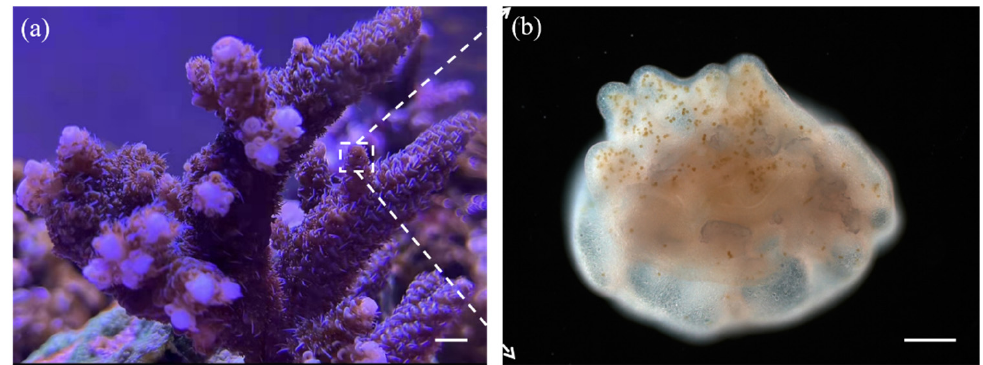
Figure 1. Coral and coral polyps. ( a ) Coral is composed of coral reefs, coral polyps and symbiosis microorganisms. (scale bar = 1 cm). ( b ) Polyps and symbiotic microorganisms; the yellow dots refer to Symbiodinium (scale bar = 1 mm).